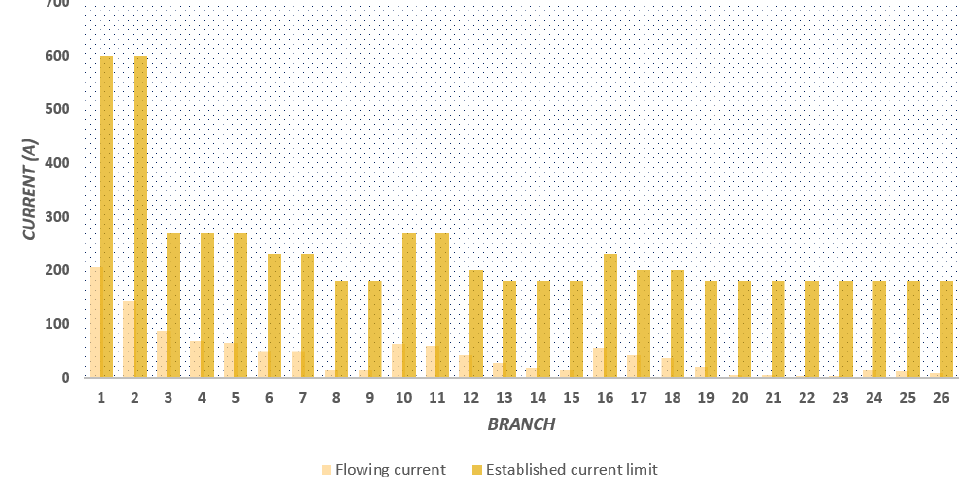
Figure 11. Country house with poor lighting.